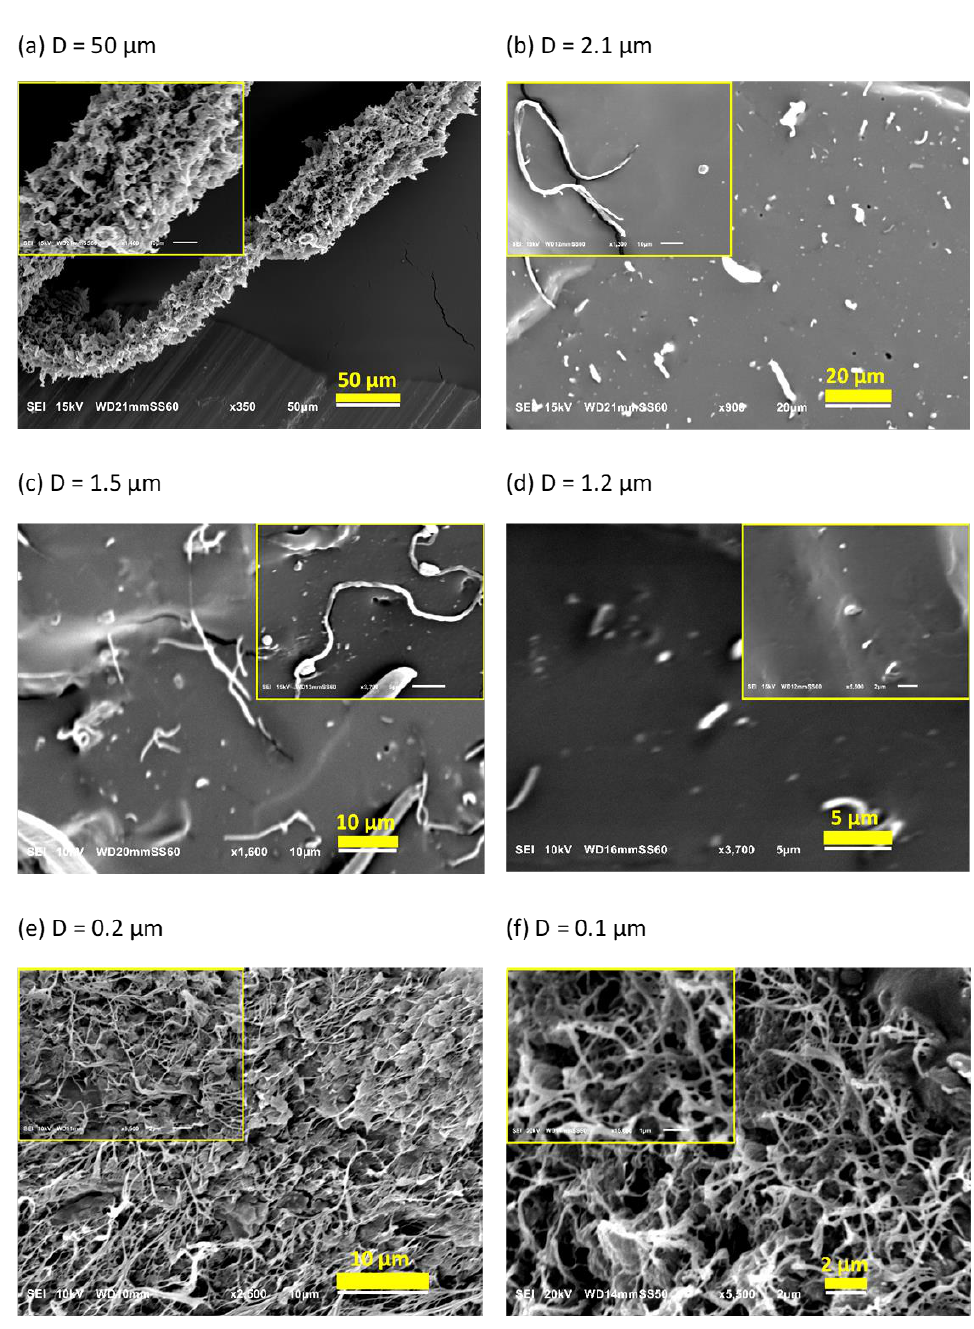
Figure 2. SEM images of: ( a ) dis-UHMWPE powder, and EOC/UHMWPE (95/5) composites processed with the shear rate of 350 s − 1 : ( b ) at 75 ◦ C for 10 min, ( c ) at 75 ◦ C for 30 min, ( d ) at 75 ◦ C for 90 min, ( e ) at 115 ◦ C for 10 min, and ( f ) at 115 ◦ C for 30 min.